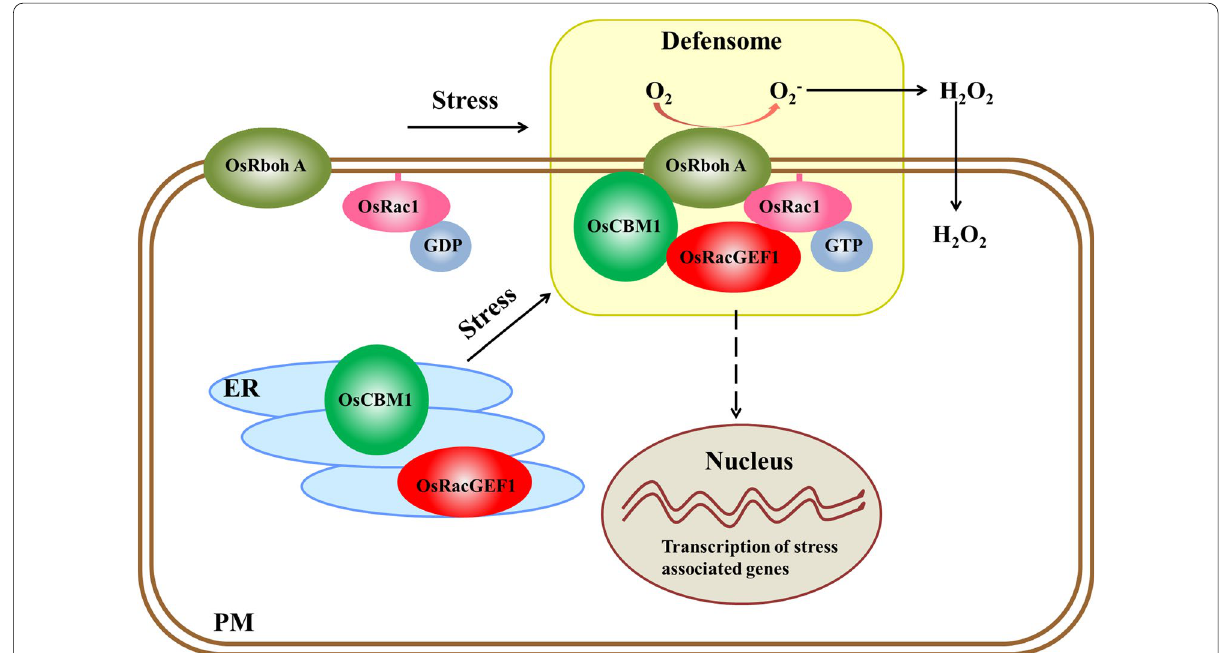
Fig. 7 Working model for OsCBM1 participating in drought‑stress tolerance by regulating NADPH oxidase‑mediated ROS production. OsCBM1 and OsRacGEF1 are co‑located at the ER. When the rice plants suffered from drought stress, OsCBM1 can be transported from the ER to the PM together with OsRacGEF1, where they formed a defensome complex with OsRbohA, and then OsRbohA was activated. The activated OsRbohA enhanced ROS production in apoplastic space, which contributed to drought‑stress tolerance of the plants possibly by regulating a set of genes